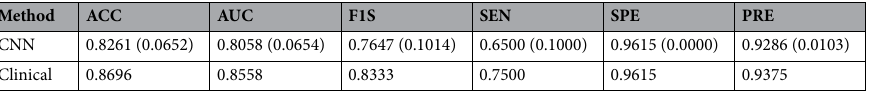
Table 2. Classification accuracy evaluation metrics with median and interquartile range (IQR) in parenthesis of the CNN classification performance over 100 runs of the data in addition to the results with the clinical interpretation with the hold-out (test) dataset.